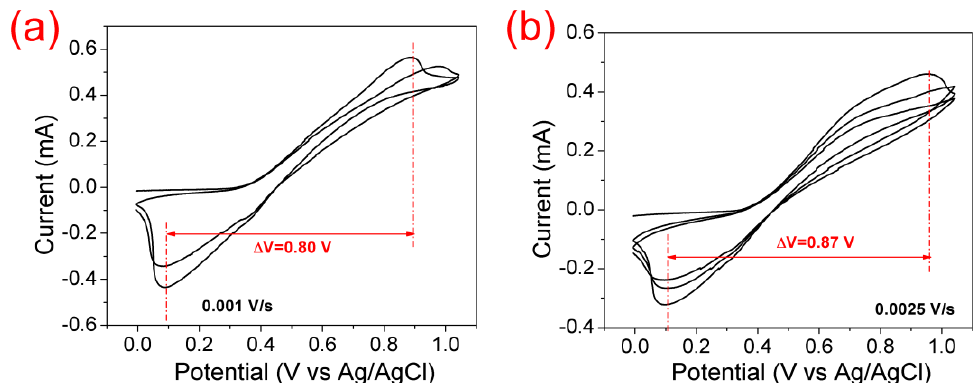
Figure 4. Cyclic voltammograms of 0.01 M I 2 –1.5 M NaI catholyte on ( a ) graphite felt GFD4.6 with WO 3 deposit and ( b ) graphite felt GFD4.6 with Nb 2 O 5 deposit. Ag/AgCl and Pt wire were used as reference and counter electrodes, respectively. The scan rates are indicated in each figure.